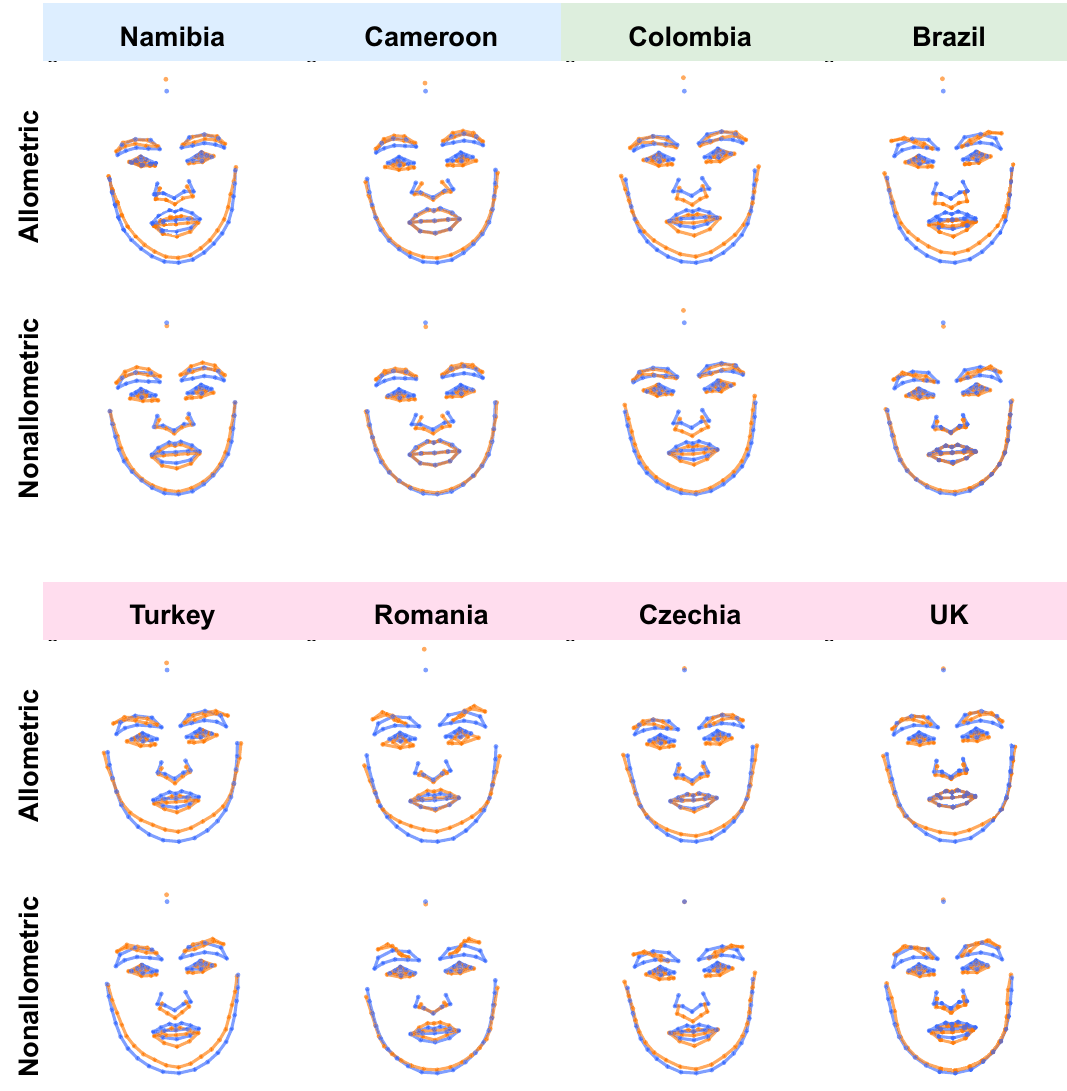
Figure 5. The depiction of allometric and non-allometric shape differences between male (blue) and female (orange) averages shown separately for each population. The shape differences were 5 × magnified for better